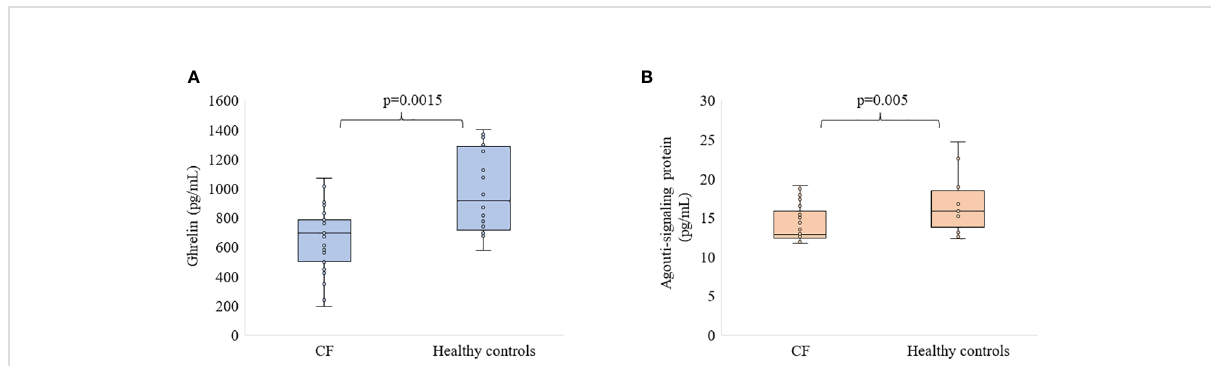
FIGURE 1 Level of ghrelin (A) and ASP (B) in patients with CF as compared to healthy